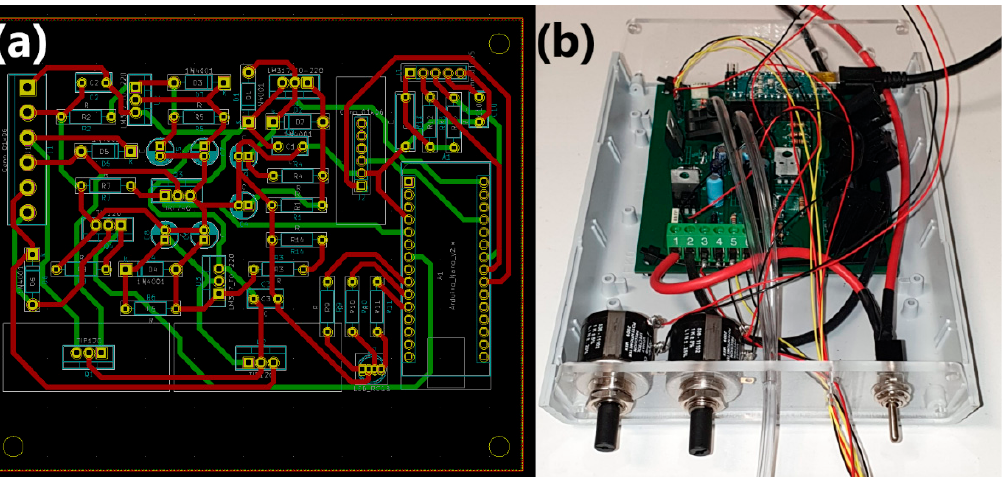
Figure 6. ( a ) PCB tracks designed through KiCad. The red tracks are arranged on the top layer, while the green ones are arranged on the bottom layer. ( b ) PCB assembled and mounted on a plastic box.